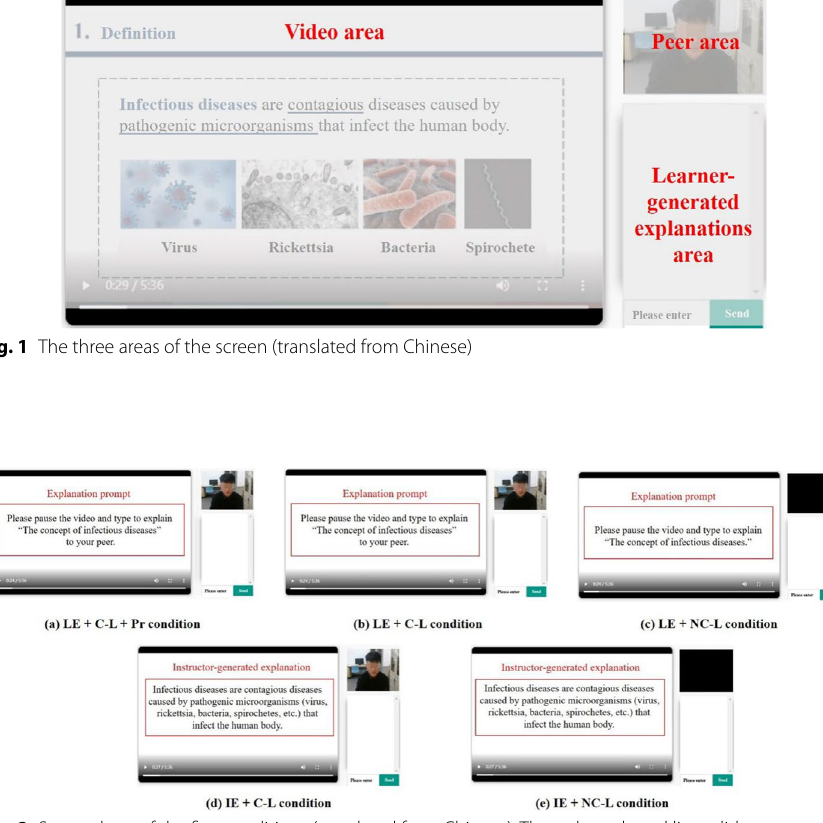
Fig. 2 Screenshots of the five conditions (translated from Chinese). The red words and lines did not appear in the video